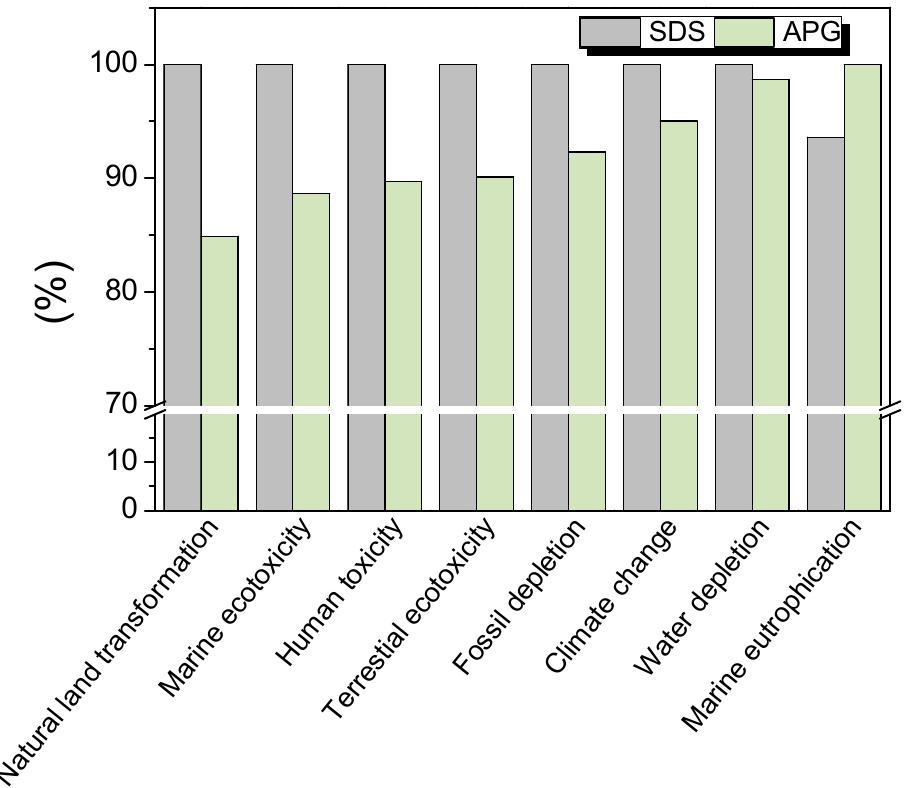
Figure 7. Environmental comparison between foam cleaning process with APG and foam cleaning process with SDS (reference system) by impact category (ReCiPe midpoint H).